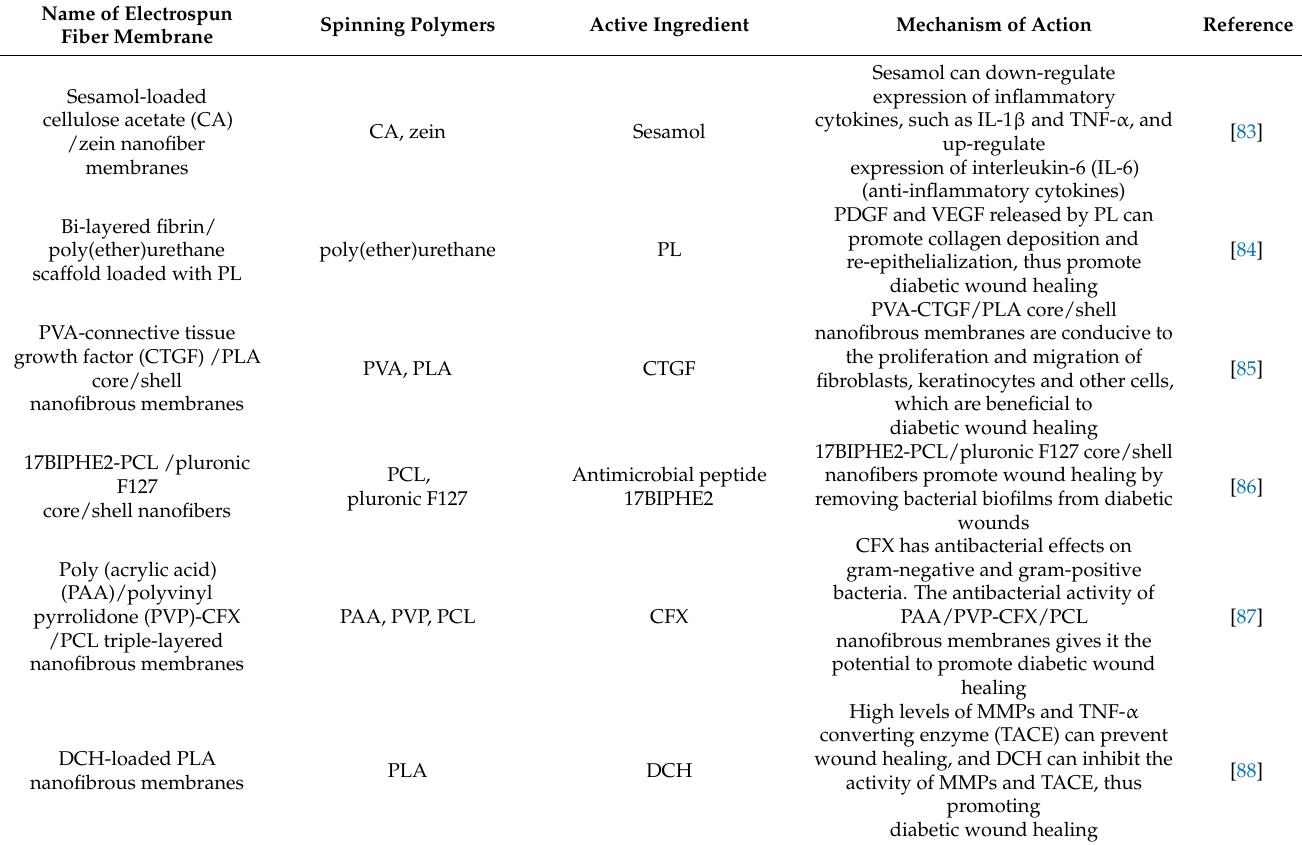
Table 2. Drug-loaded electrospun fibers for collaborative therapy of diabetic